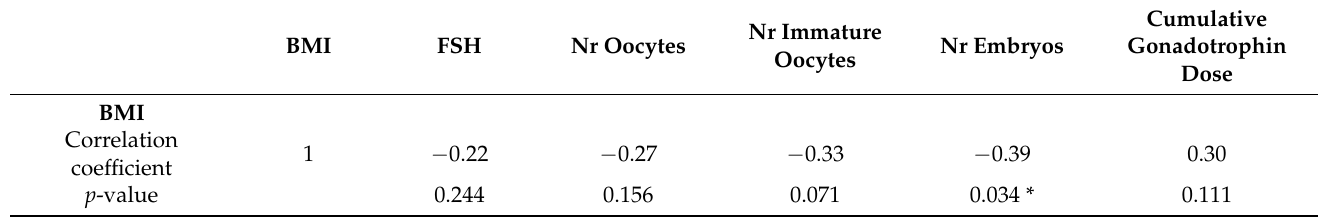
Table 5. Spearman’s correlation POR patients. Statistically significant differences are marked with an asterisk ( p -value <